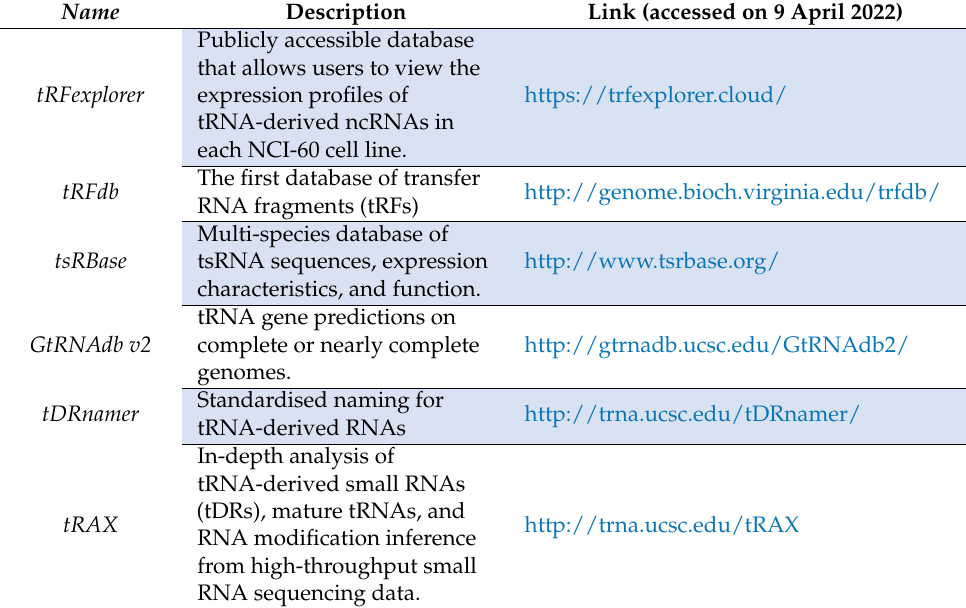
Table 6. tiRNAs and tFRs databases including mammals and other